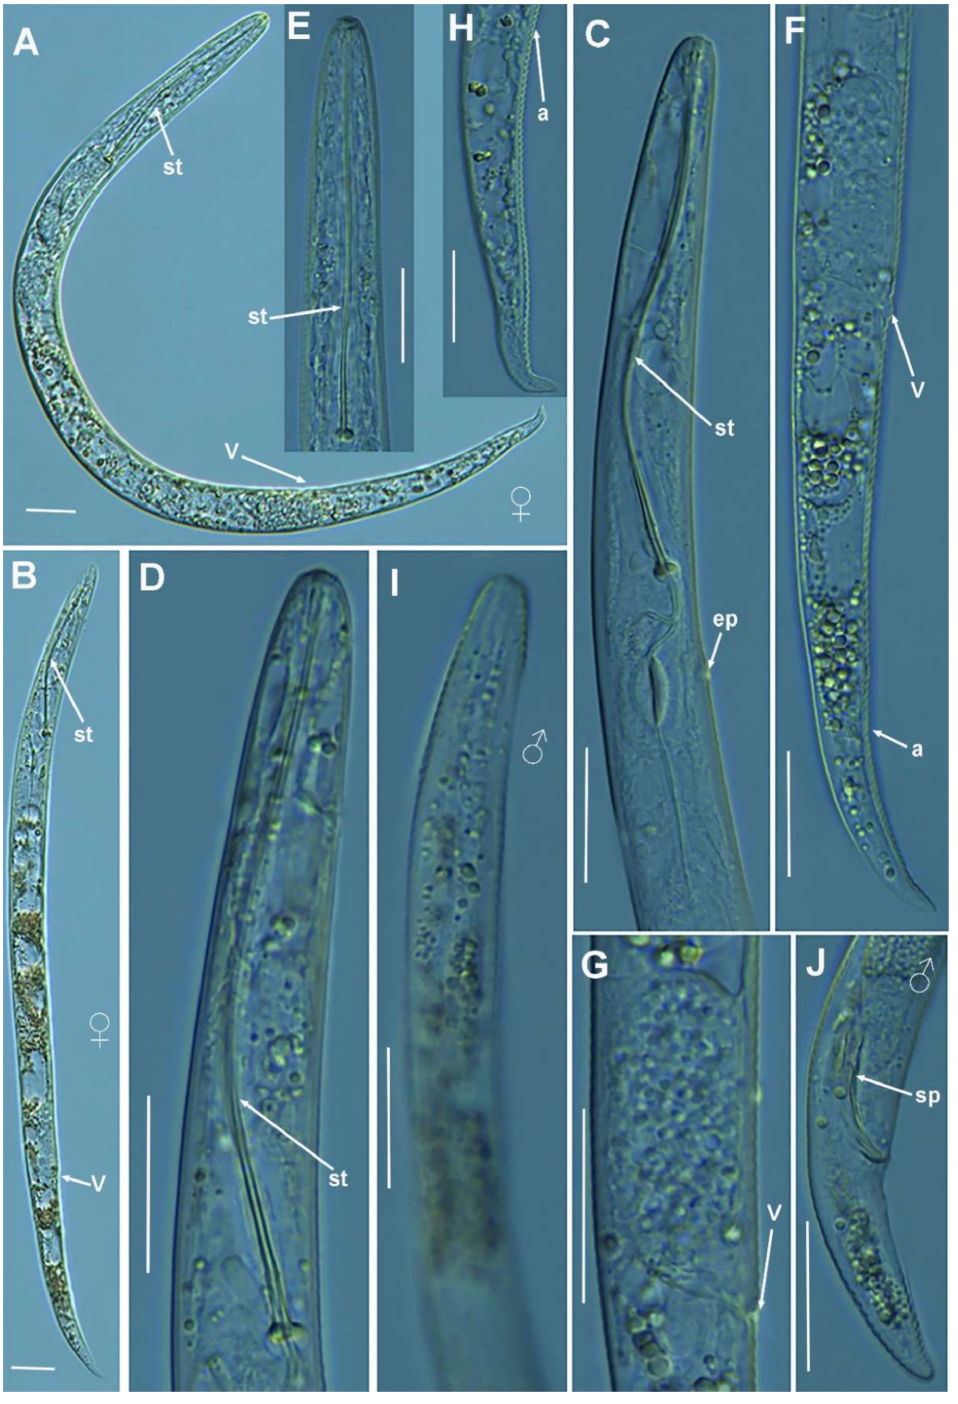
Figure 7. Light photomicrographs of Paratylenchus macrodorus Brzeski, 1963. ( A , B ) Entire female with stylet and vulva arrowed; ( C ) female pharyngeal region; ( D , E ) female lip region; ( F ) female posterior region with vulva and anus (arrowed); ( G ) detail of vulva (arrowed); ( H ) female tail region with anus arrowed; ( I ) male pharyngeal region showing absence of stylet; ( J ) male posterior region showing spicules (arrowed). Scale bars ( A – J = 20 µ m). (Abbreviations: a = anus; ep = excretory pore; sp = spicules; st = stylet; V =